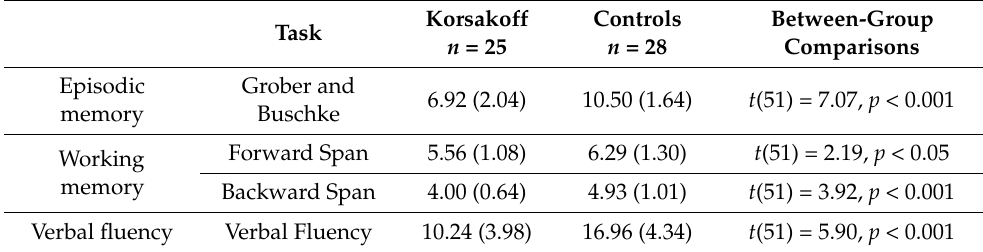
Table 1. Cognitive performances of Korsakoff patients and control participants.